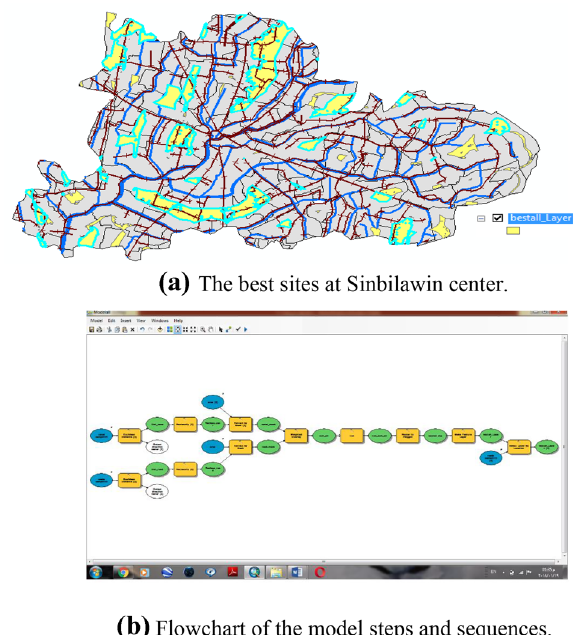
Figure 6. (a) The best sites at Sinbilawin center. (b) Flowchart of the model steps and sequences.